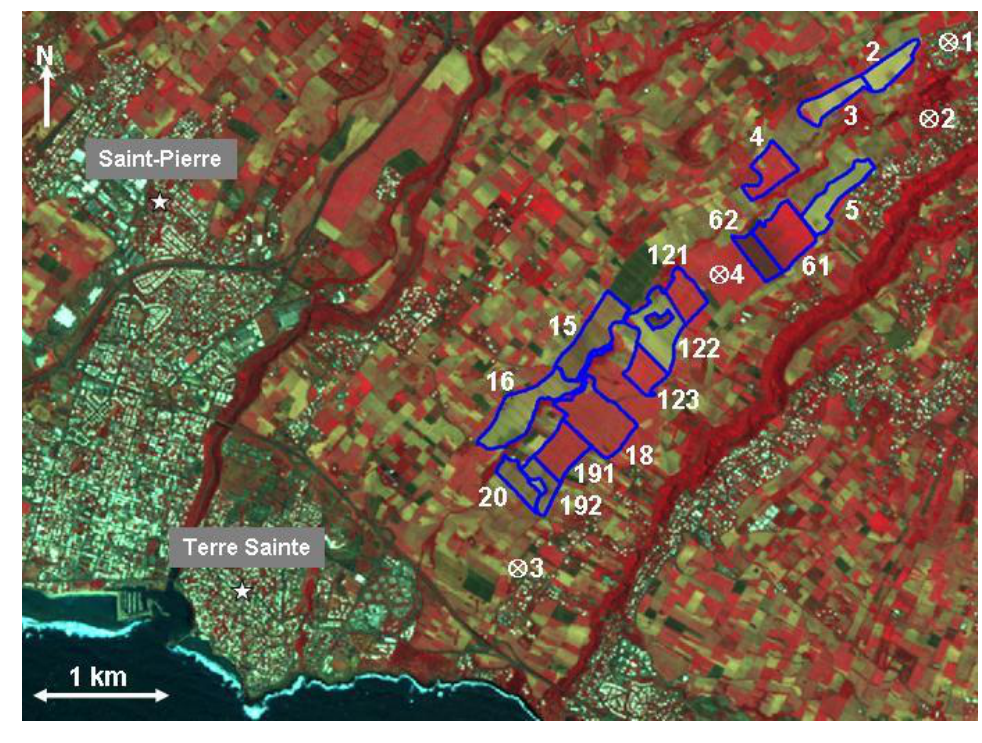
Figure 1. A false color composite of a SPOT-5 image acquired over the study site in Reunion Island on October 21, 2008 (Red: band-3; Green: band-2; Blue: band-1). Reference sugarcane fields are outlined in blue. ―  ‖ indicates the location of